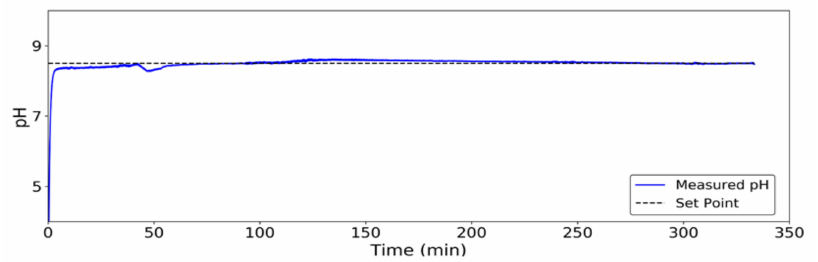
Figure 3. pH control by PID-Time Proportional control during test